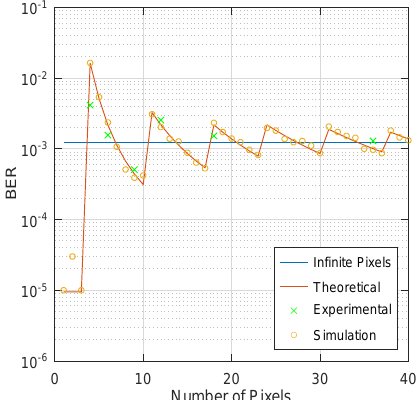
Figure 7. Theoretical results (red curve) generated by Equation (5), simulation results (yellow circle) and experimental results (green cross) are presented. The blue line is plotted assuming an infinite number of pixels (i.e., ∆ V = 0). E b is set at 6.6 dB based on experimental N 0